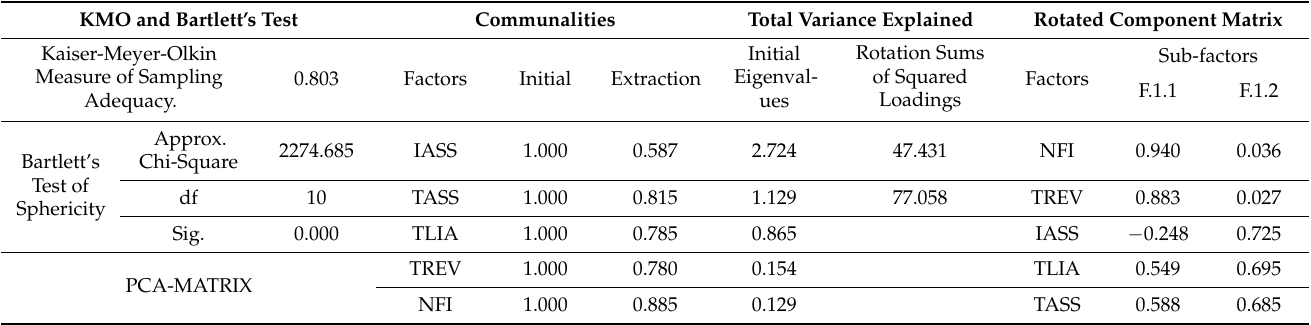
Table 3. Results of sustainable profit factor in business through factor analysis.